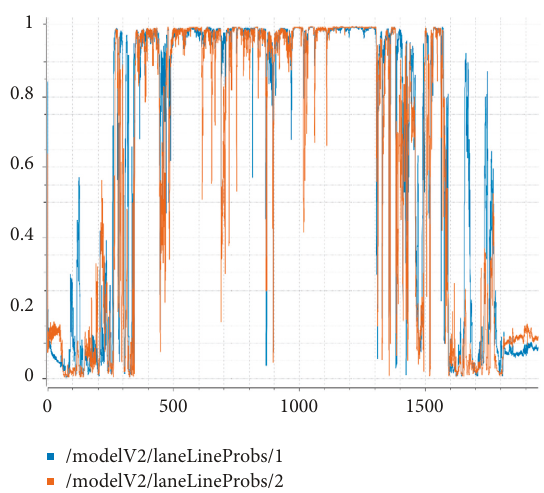
Figure 7: T1D2 left (1) and right (2) lane